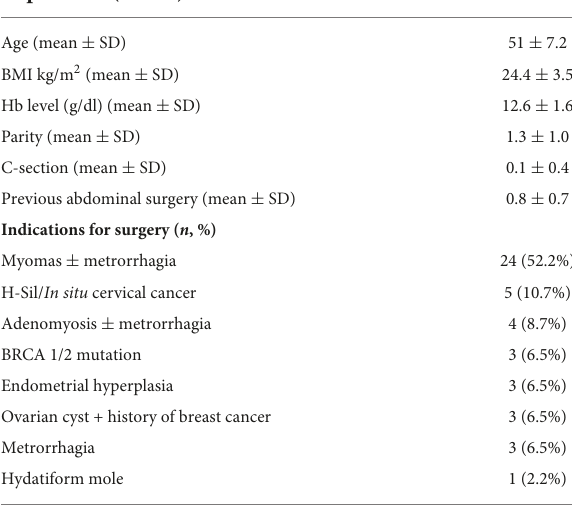
TABLE 1 Population features analysis and description ( n =